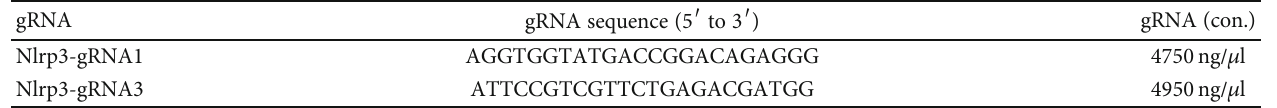
Table 1: The sequence and concentration of gRNA used in NLRP3 KO. gRNA